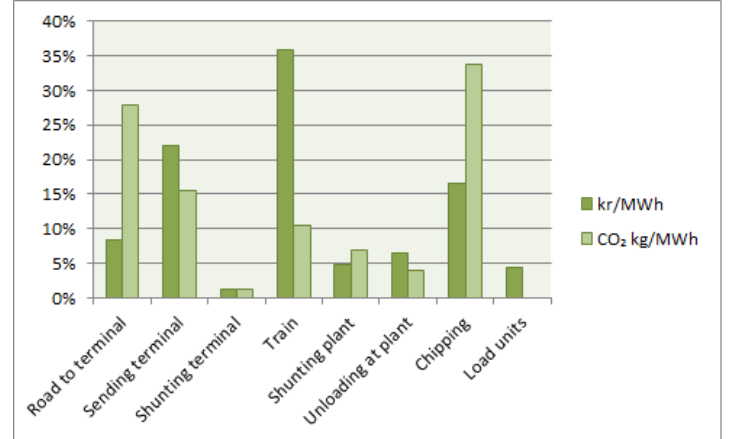
Figure 20. Distribution of costs and CO 2 emissions for the best case